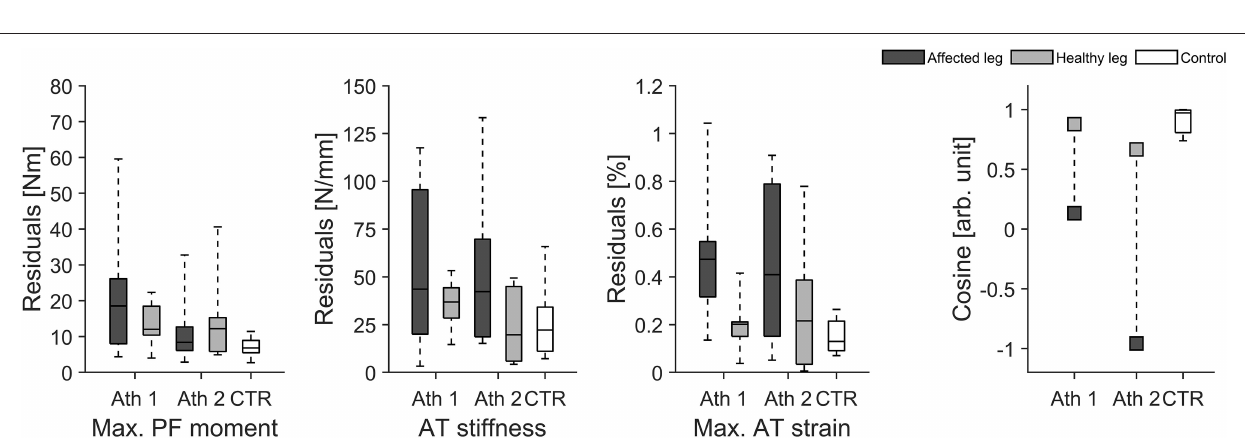
FIGURE 5 | Box plots of residuals in muscle strength (Max. PF moment), tendon stiffness (AT stiffness) and maximal tendon strain (Max. AT strain) as well as the cosine similarity (Cosine) of the relative changes of muscle strength and tendon stiffness between sessions over the 1 year observation period for the affected and healthy leg in two elite jumpers (Ath 1 and Ath 2) with chronic AT tendinopathy and in the control group (CTR; take-off leg; n = 12).